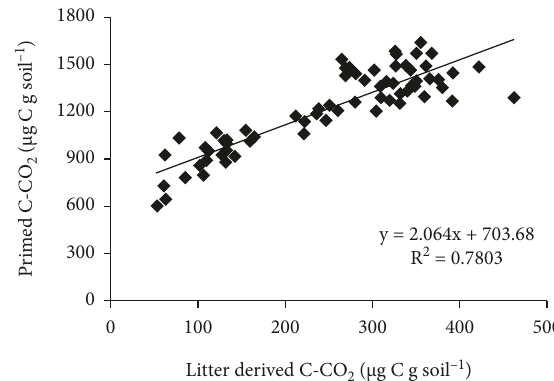
Figure 4: Correlation between litter-derived CO